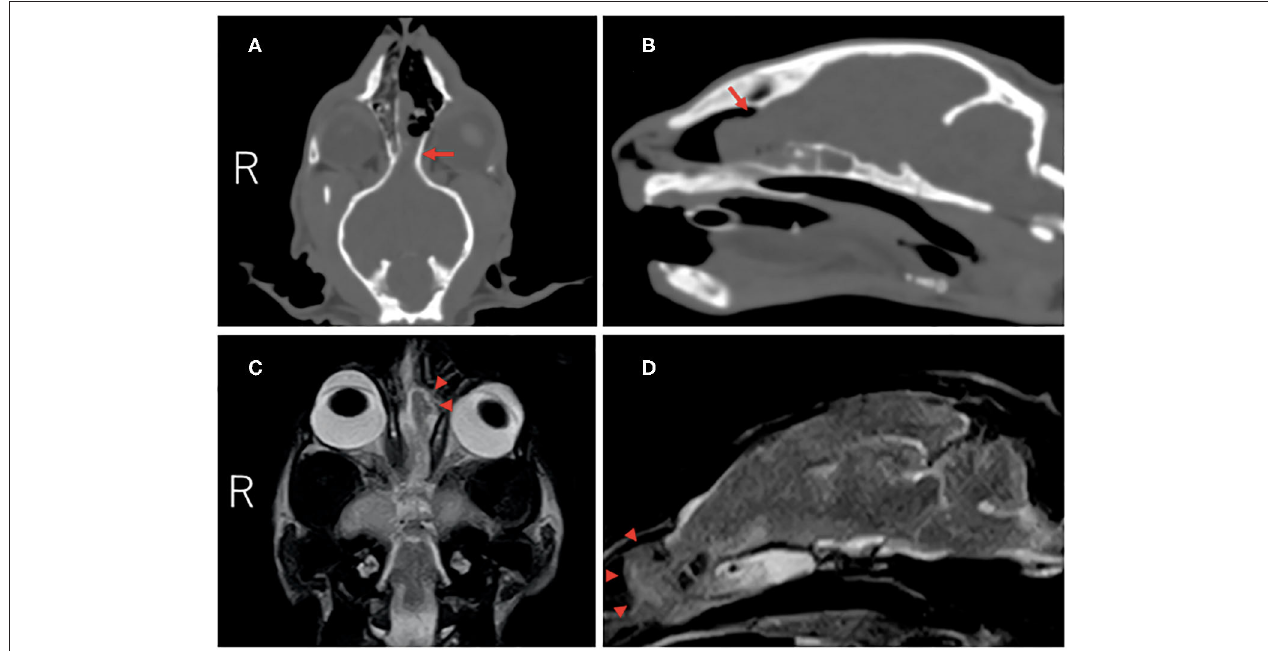
FIGURE 1 | CT and MR images of the cranium and brain at diagnosis. Dorsal (A) and parasagittal (B) CT images showed the defect of the left cribriform plate (red arrow). On dorsal (C) and parasagittal (D) T2-weighted MR images, the left olfactory bulb protruded into the nasal cavity through the defect (red